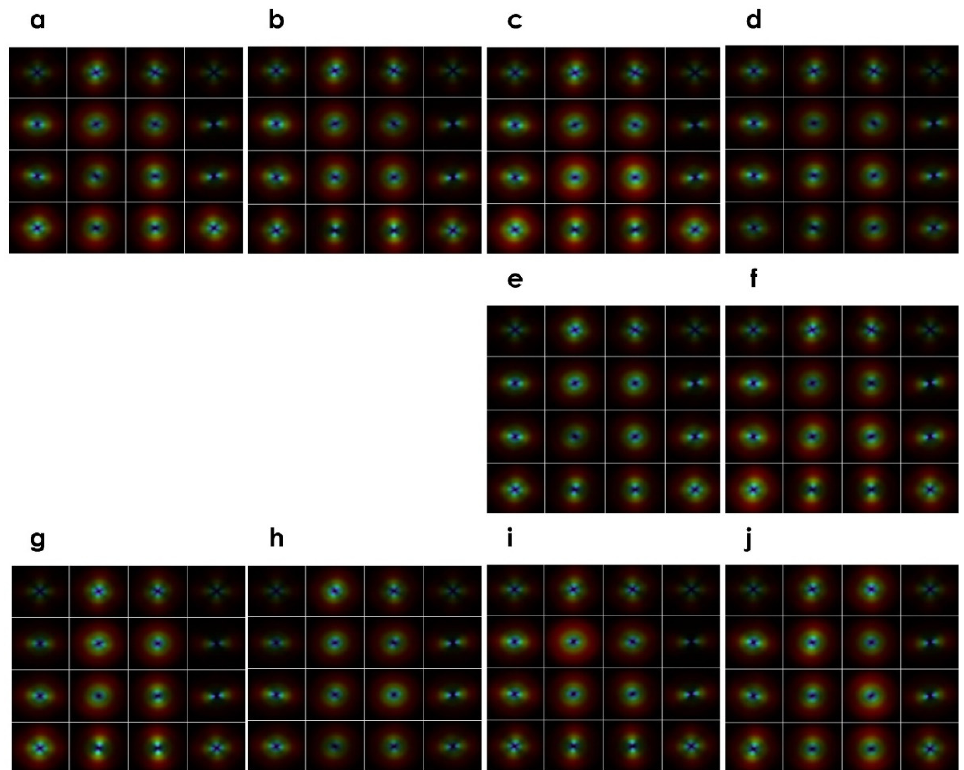
Figure 6. Gist descriptor: ( a ) normal, ( b ) complete endocardial cushion defect, ( c ) CCTGA, ( d ) my- ocardial tumor, ( e ) Ebstein’s anomaly, ( f ) hypoplastic RV, ( g ) hypoplastic LV, ( h ) tricuspid atresia, ( i ) mitral and tricuspid stenosis, and ( j ) bald LA in TAPVC . HOS are the spectral representation of the moments and cumulants from the third order and beyond. Cumulants are computed using certain nonlinear mixtures of moments [72]. Although the process is random, cumulants are deterministic functions. It is noted that, in the spectral domain, cumulant spectra are determined using moment spectra [72]. Herein, fetal heart US images are analyzed for order n = 3 and a step angle of 10 degrees (refer to Figure 7).